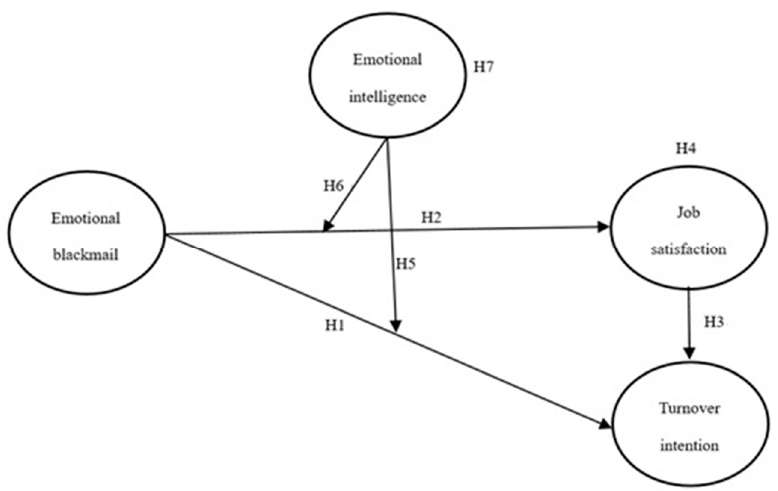
Figure 1. Research framework.